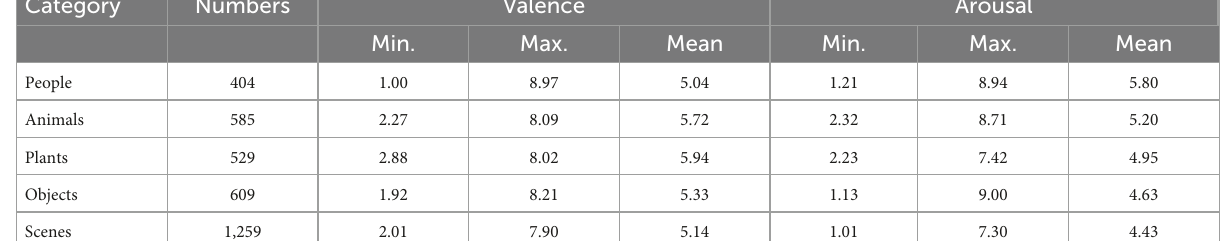
TABLE 4 Descriptive statistics of the material library.